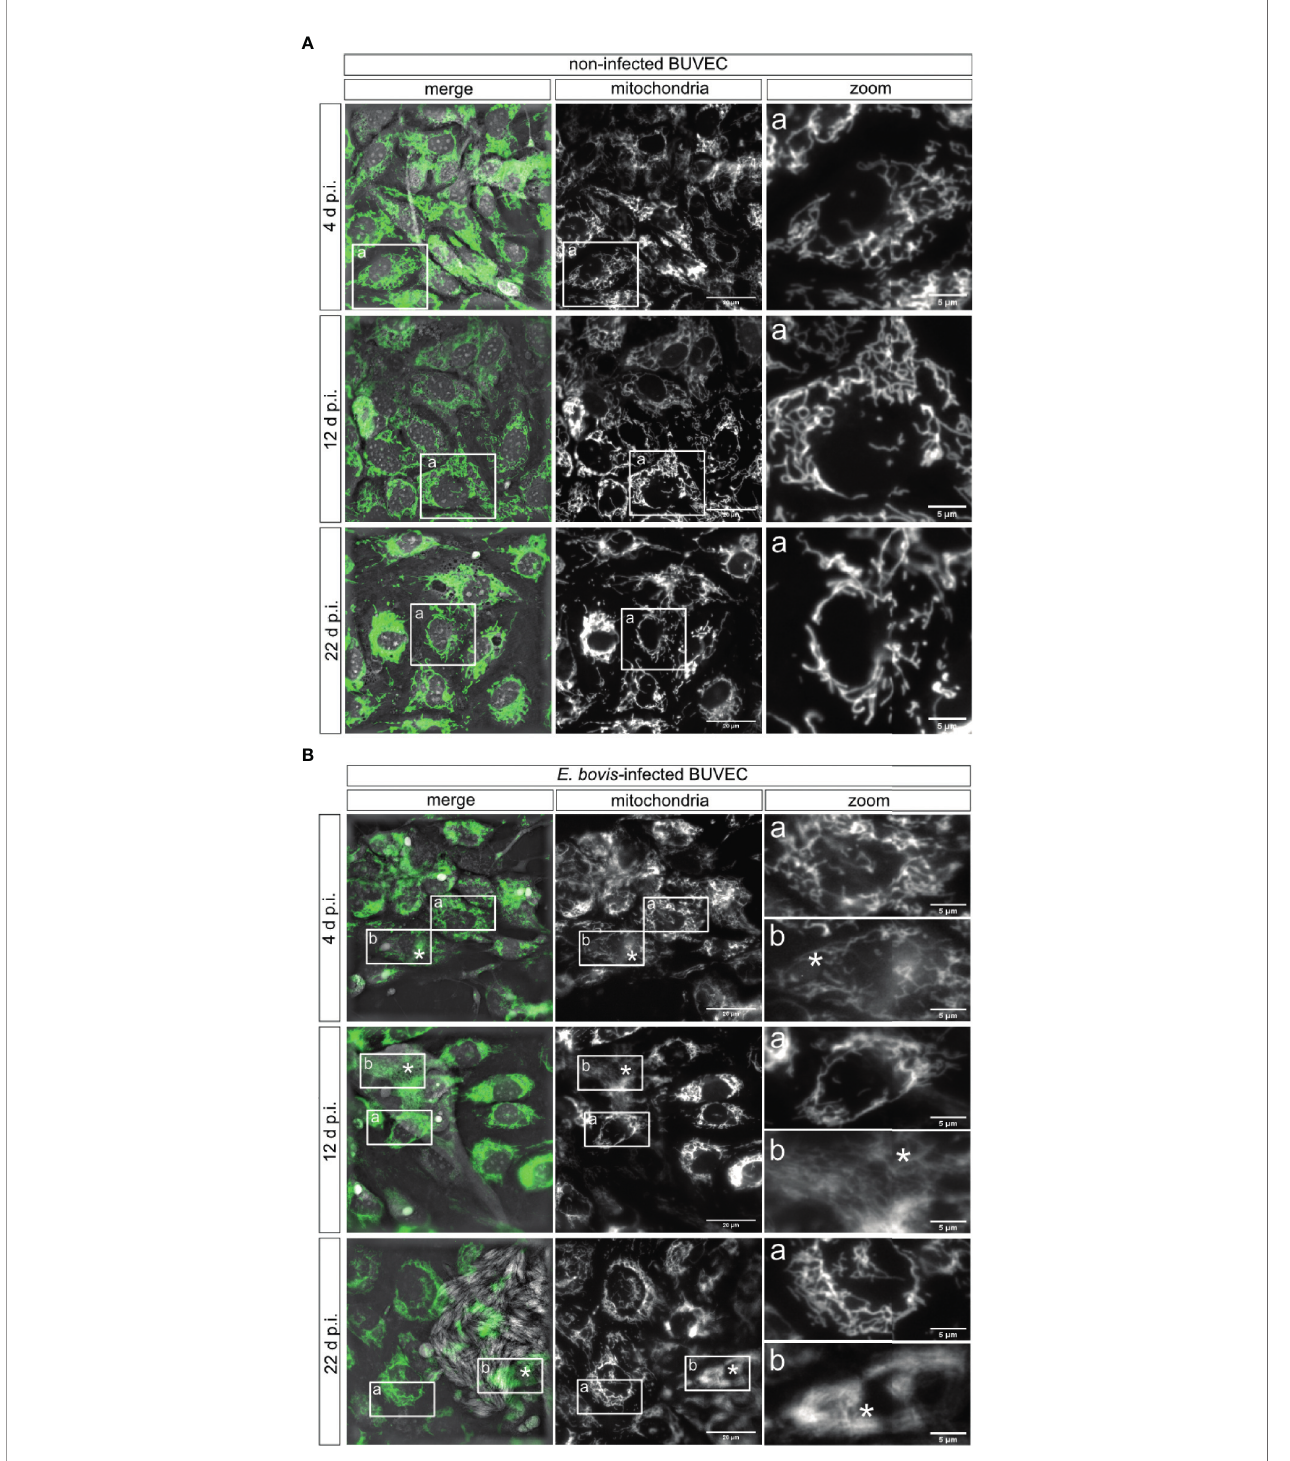
FIGURE 5 | Mitochondrial morphology of E. bovis – infected host cells. Non-infected controls (A) and E. bovis – infected BUVEC (n = 3) (B) were stained with a mitochondrial probe independent on the mitochondrial potential (Mitoview, green) to visualize mitochondrial morphology. The mitochondrial structure ( fl uorescence) was registered at 4, 12, and 22 days p. i. The images are representative of three biological replicates and are shown in grayscale for visualization purposes. (A-a) Inset square in mitochondria and merge images are shown in the zoom panel to observe the mitochondria network in one cell. (B-a, b) Inset rectangles in mitochondria and merge images are shown in the zoom column to identify the mitochondria shape in non-infected cells (a) and E. bovis – infected cells (b) in only one cell. Asterisks identify the parasite localization in the image. *p =